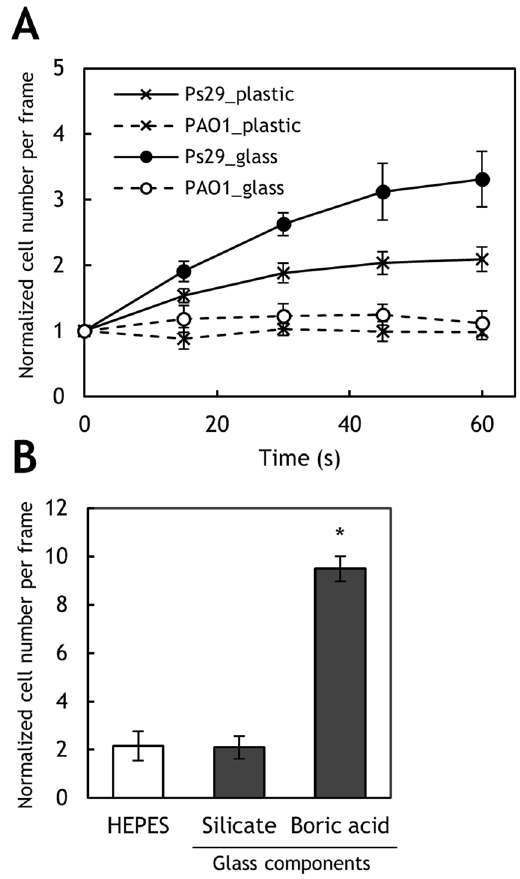
Figure 1. Discovery of chemotaxis to boric acid. ( A ) Chemotaxis toward negative control HEPES buffer by R. pseudosolanacearum Ps29 and P. aeruginosa PAO1. ‘Plastic’ and ‘glass’ indicate HEPES buffer stored in a plastic tube and glass bottle, respectively. ( B ) Chemotaxis toward 5 mM silicate and 0.5 mM boric acid by R. pseudosolanacearum Ps29. HEPES stored in a plastic tube was used as a control. The normalized cell number was calculated by dividing the number of bacterial cells observed at 1 min by the number observed at the initiation of the experiment. Vertical bars represent the standard error of measurement for experiments performed at least in triplicate. Asterisk indicates a statistically significant difference compared with the response to buffer ( P < 0.05 by Student’s t